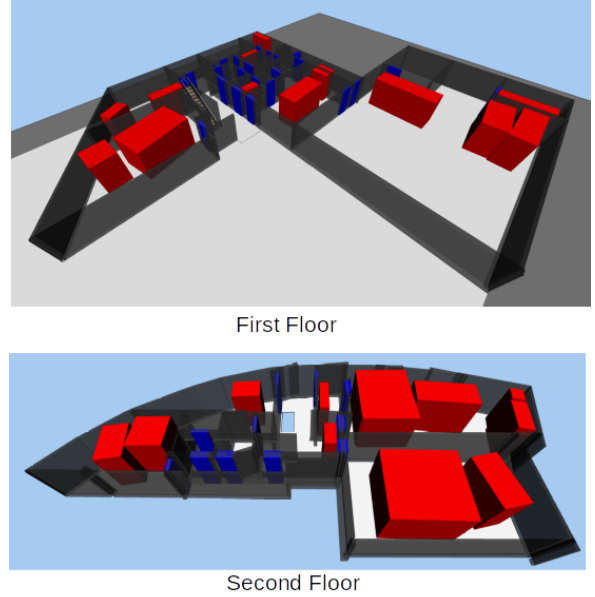
Figure 4: 3D model with doors (blue) and furniture as obstacles (red boxes)